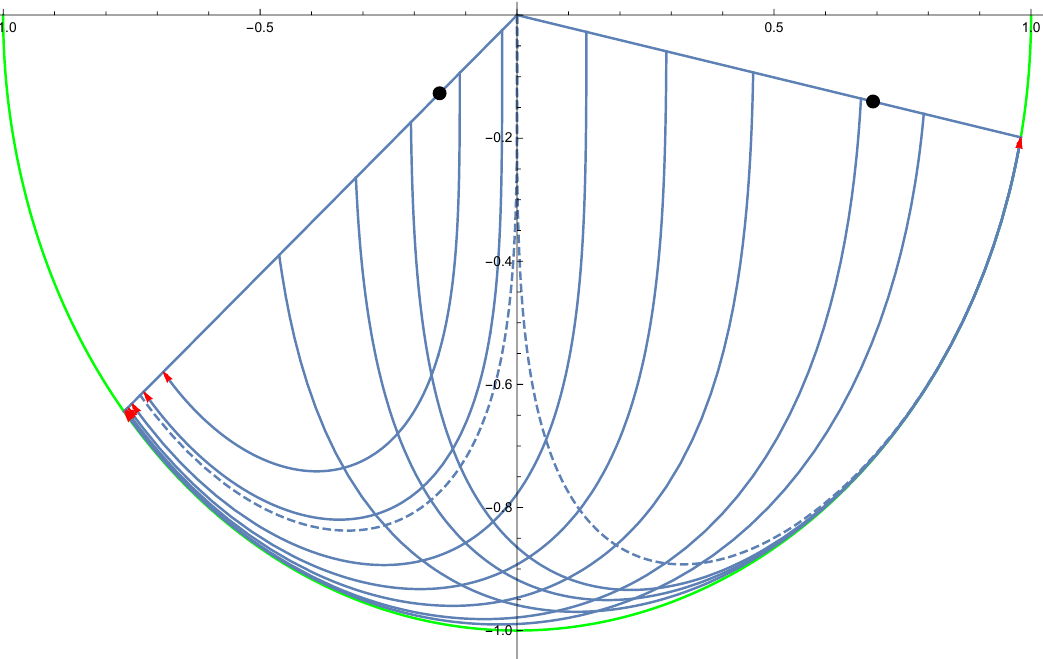
Figure 4. The space of curves with θ 1 = 0 . 7 , θ 2 = 0 . 2 . Neumann ends are denoted by red arrows, Dirichlet ends are unmarked. The black dots denote the D-walls, the dashed lines are the curves that connect the critical anchor to